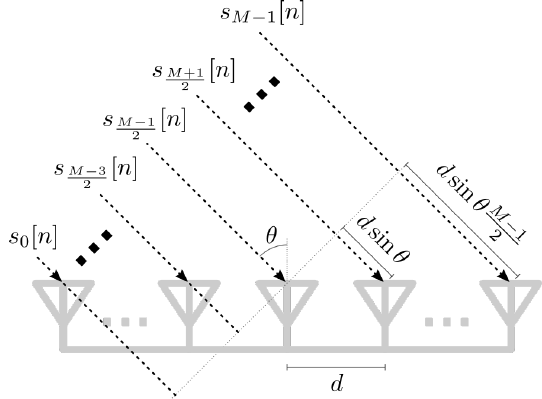
Figure 2. Structure of an ULA arrangement with M